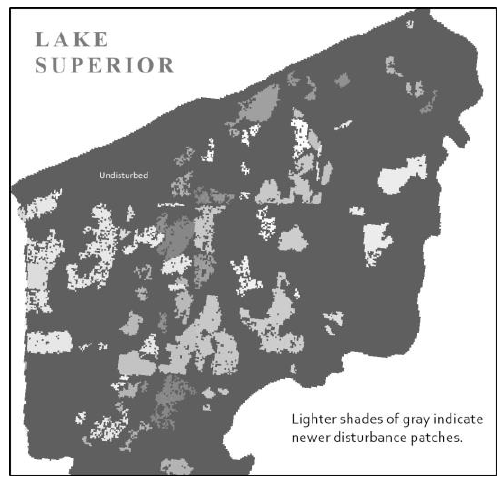
Figure 3. Distribution of disturbance patches across the northern half of the burn scar. Dark gray background indicates the boundary of the fire. Light color patches indicate pre-2012 disturbance identified by